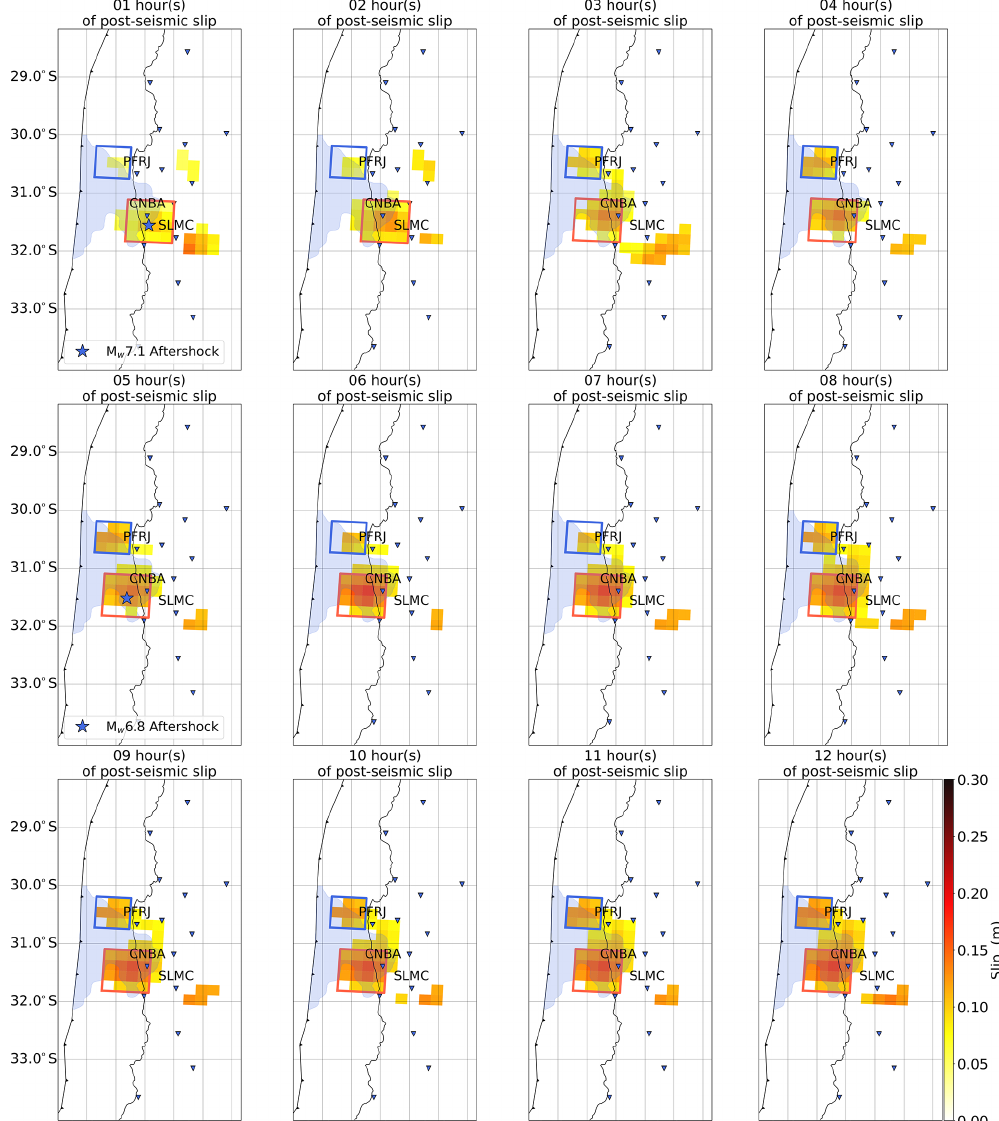
Figure 3. Hourly map of the post-seismic slip distribution over the first 12h after the mainshock. Each model is obtained after averaging 40000 models, each weighted by the inverse of its misfit value. Sub-faults with slip amplitude lower than the standard deviation are set to 0. The light blue area shows the co-seismic slip region obtained by Melgar et al. (2016). The blue stars show the two largest aftershocks in the GCMT catalog at their time of occurrence. The blue square outlines what we refer to as the northern patch in the text while the red square outlines what we refer to as the southern